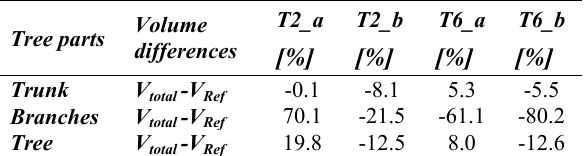
Table 3. Volume differences of data set B for V total -V Ref split into trunk, branches and tree. _a indicates scan epoch 1 and _b indicates scan epoch 2.